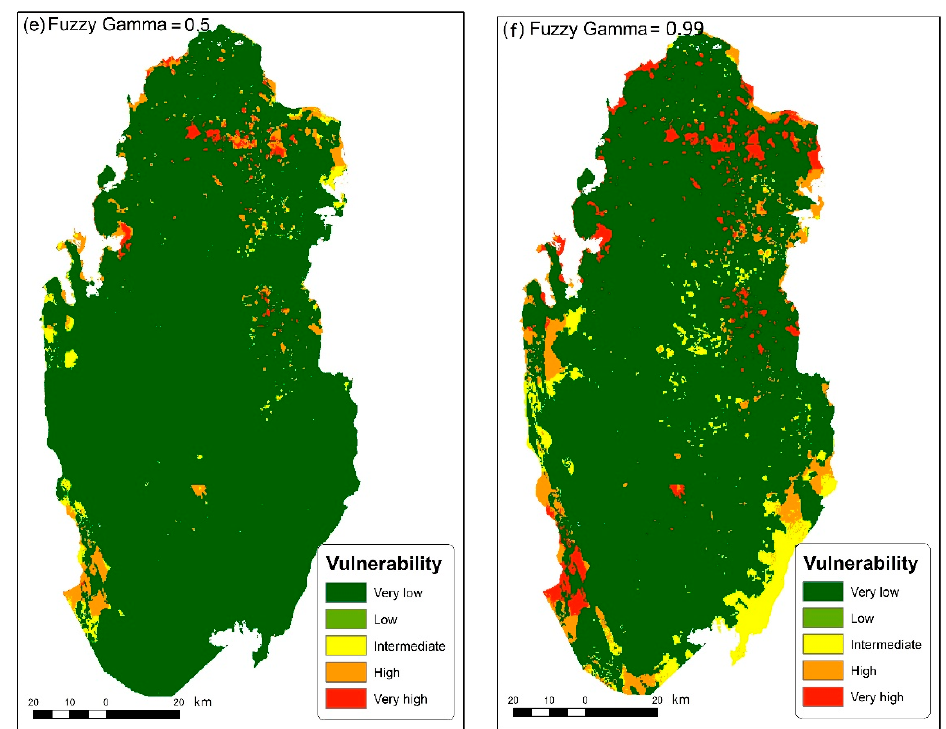
Figure 5. Vulnerability map using ( a ) Fuzzy And, ( b ) Fuzzy Or, ( c ) Fuzzy Sum, ( d ) Fuzzy Product, ( e ) Fuzzy Gamma = 0.5, and ( f ) Fuzzy Gamma = 0.99.